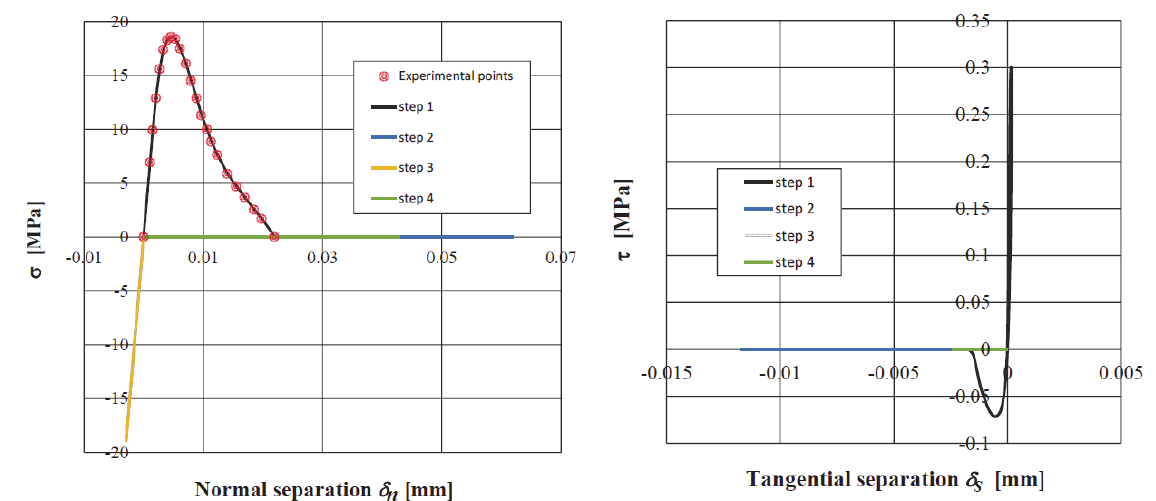
Figure 10: Traction-separation curves (  n and  s ) of the representative point P1 at the